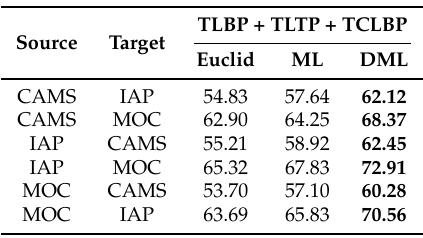
Table 6. After IGC and FN, cross-domain classification accuracies (%) of concatenating the TLBP, TLTP and TCLBP to form a feature vector for representing the cloud image with different metrics.